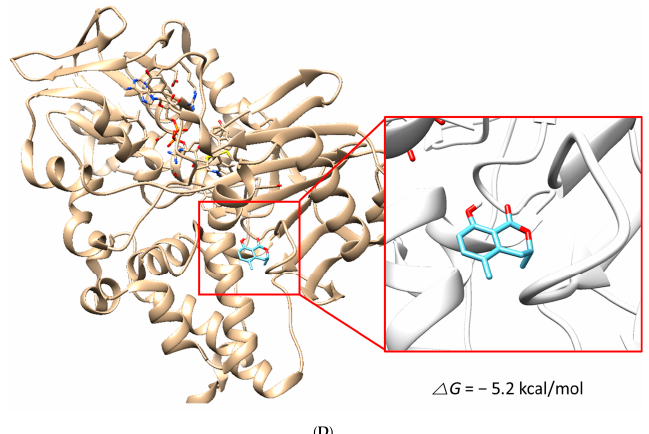
Figure 5. Docking simulation of 5-methylmellein ( S -form) with hMAO-A (2Z5X) ( A ) and hMAO-B (3PO7) ( B ) and of R -form with hMAO-A ( C ) and hMAO-B ( D ), as determined by the UCSF Chimera. The S - and R -forms interacted with hMAO-A through a hydrogen bond with Phe208 residue (distance: 1.972 Å) and Asn181 residue (distance: 2.375 Å), respectively. 3.8. In Silico Pharmacokinetics of 5MM The pharmacokinetic analysis of 5MM was performed using the SwissADME web tool. 5MM exhibited high gastrointestinal absorption, permeability to the BBB, and inhibition of CYP1A2 (Table 3). In addition, the results of the Lipinski parameters showed that 5MM did not violate Lipinski’s five rules (Table 4). These results can yield benefits when 5MM is used as a central nervous system (CNS) drug. Table 3. Predicted pharmacokinetic properties of 5MM.